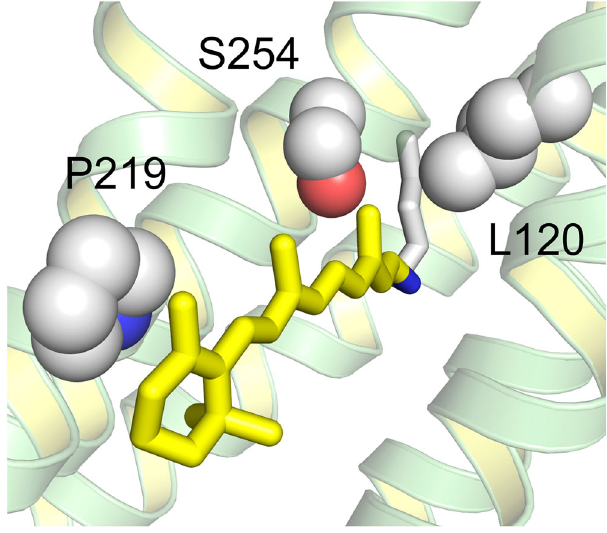
Fig. 1 Color switches of microbial rhodopsins, shown in the structure of a light-driven sodium pump KR2. KR2 has L120, S254, and P219 in the L/Q switch, A/TS switch, and G/P switch,